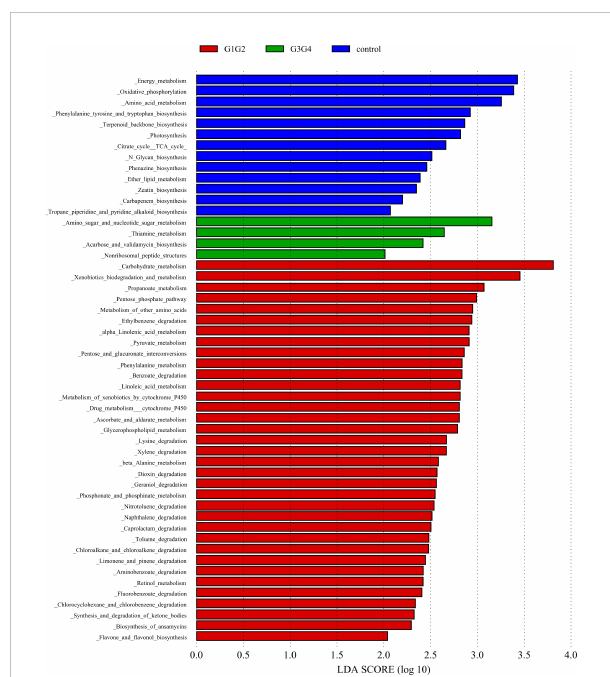
FIGURE 6 Signi fi cant differences in relative abundance identi fi ed by LEfSe analysis between the three groups (Control, G1G2 and G3G4). In the metabolism function module (level 3), the untreated group(control) is shown in blue, the intensive treatment group(G1G2) in red and the consolidation treatment group(G3G4) in green. The length of the column represents the in fl uence of signi fi cantly different species in relative abundance (LDA scores >